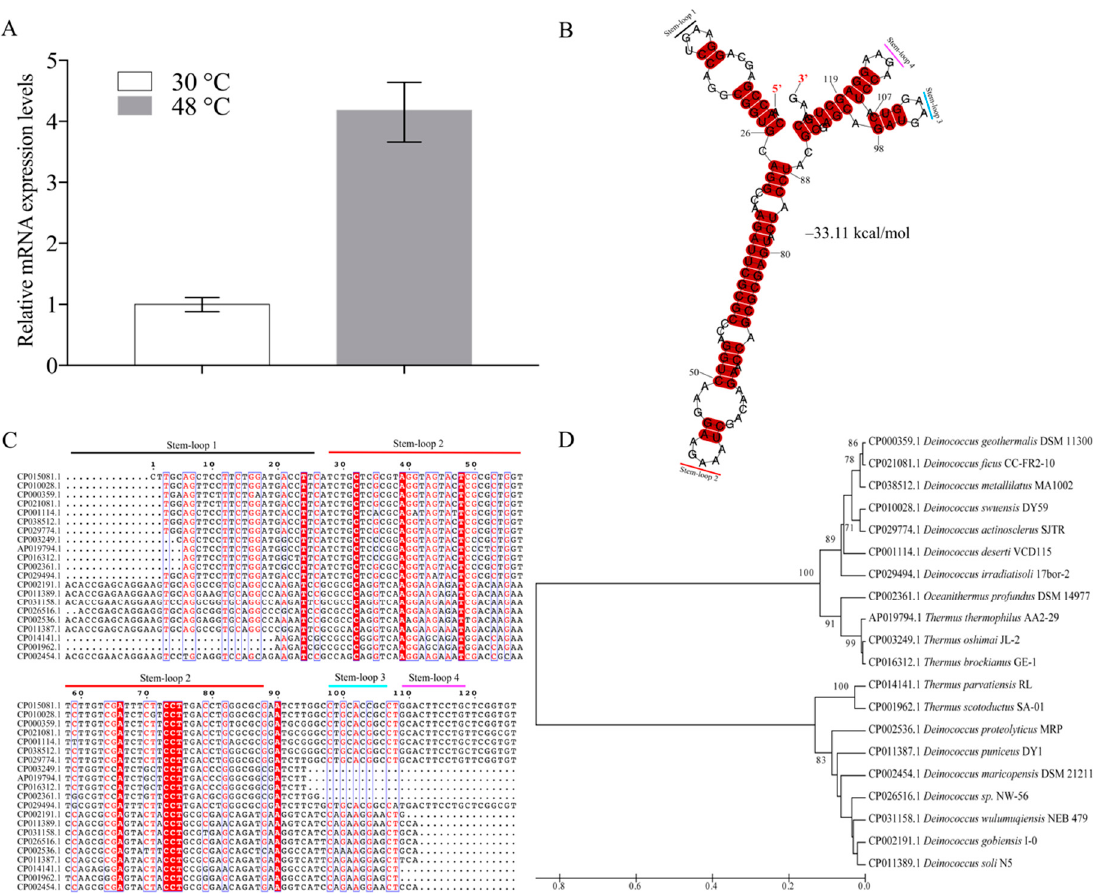
Figure 1. Secondary structure, multi-sequence alignment, and phylogenetic analysis of dsr11 . ( A ) The expression of dsr11 under heat stress in D. radiodurans wild-type (WT) by qRT-PCR. ( B ) dsr11 consisted of four stem-loop structures with free energy of − 33.11 kcal / mol, and the stem-loops were numbered. ( C ) The multi-sequence alignment was performed using Clustal X2 and then manually refined. The sequences were divided into four clusters. The sequences of stem-loop 2 were highly similar to other homologs. ( D ) The guide tree reflects the similarity relations between the homologous sequences in the form of hierarchical clustering. It is constructed by the UPGMA method by MEGA 7.0.